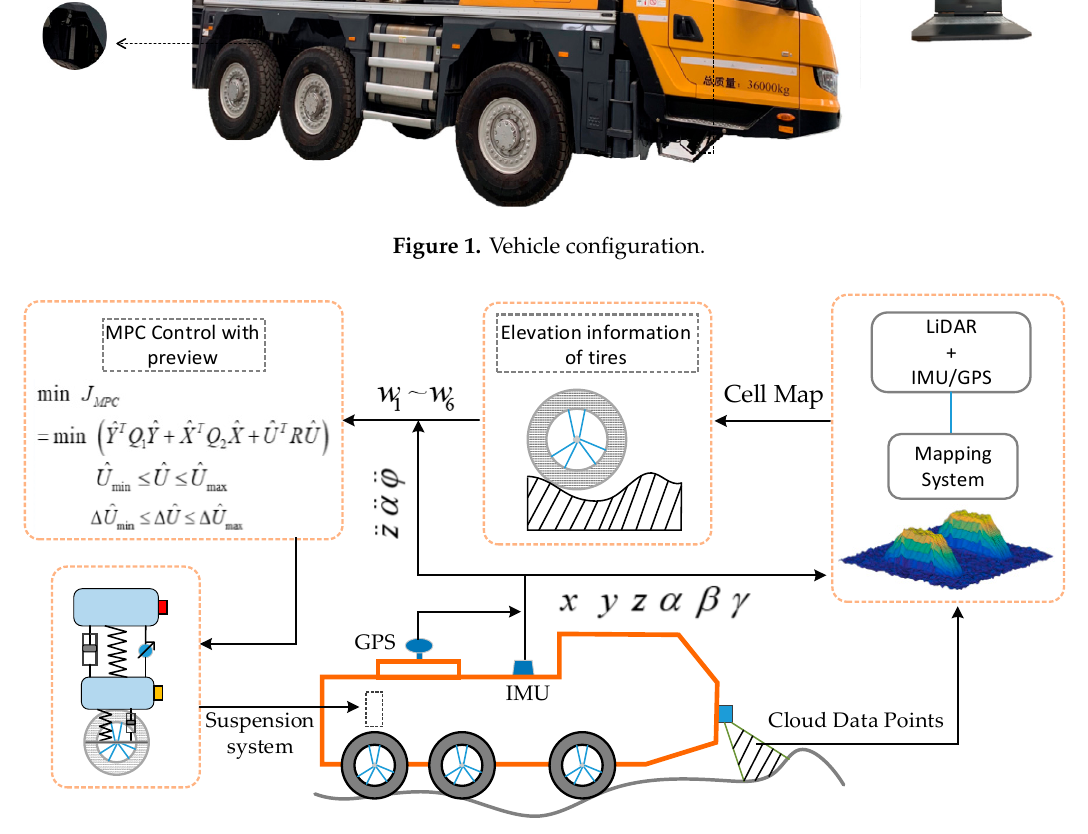
Figure 2. System Figure 2. System structure. Figure 2. System structure.